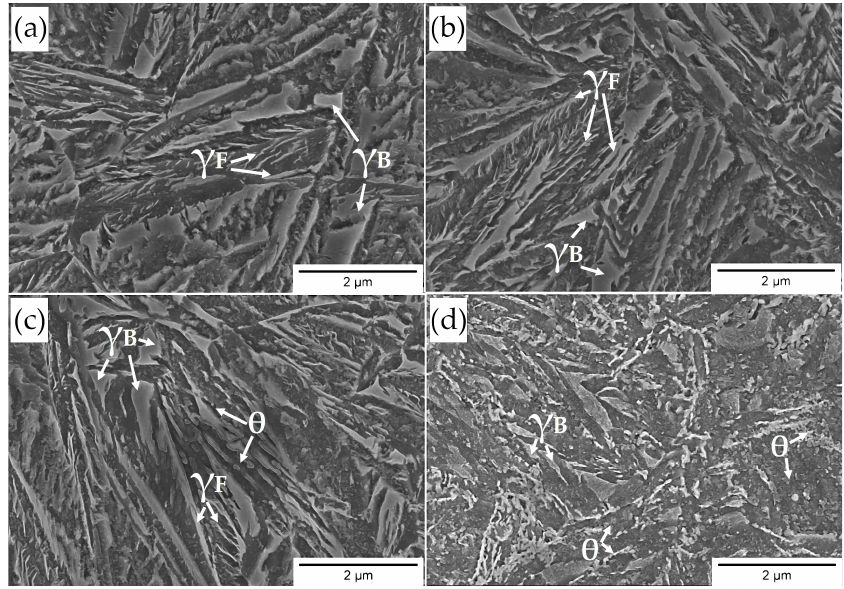
Figure 14. Microstructure of experimental steel subjected to isothermal heat treatment and tempering process: ( a ) Isothermal heat treatment at 280 ◦ C before tempering; ( b ) tempering at 350 ◦ C; ( c ) tempering at 400 ◦ C; ( d ) tempering at 550 ◦ C. SEM, secondary electrons detector. γ F —film-like retained austenite; γ B —blocky retained austenite; θ